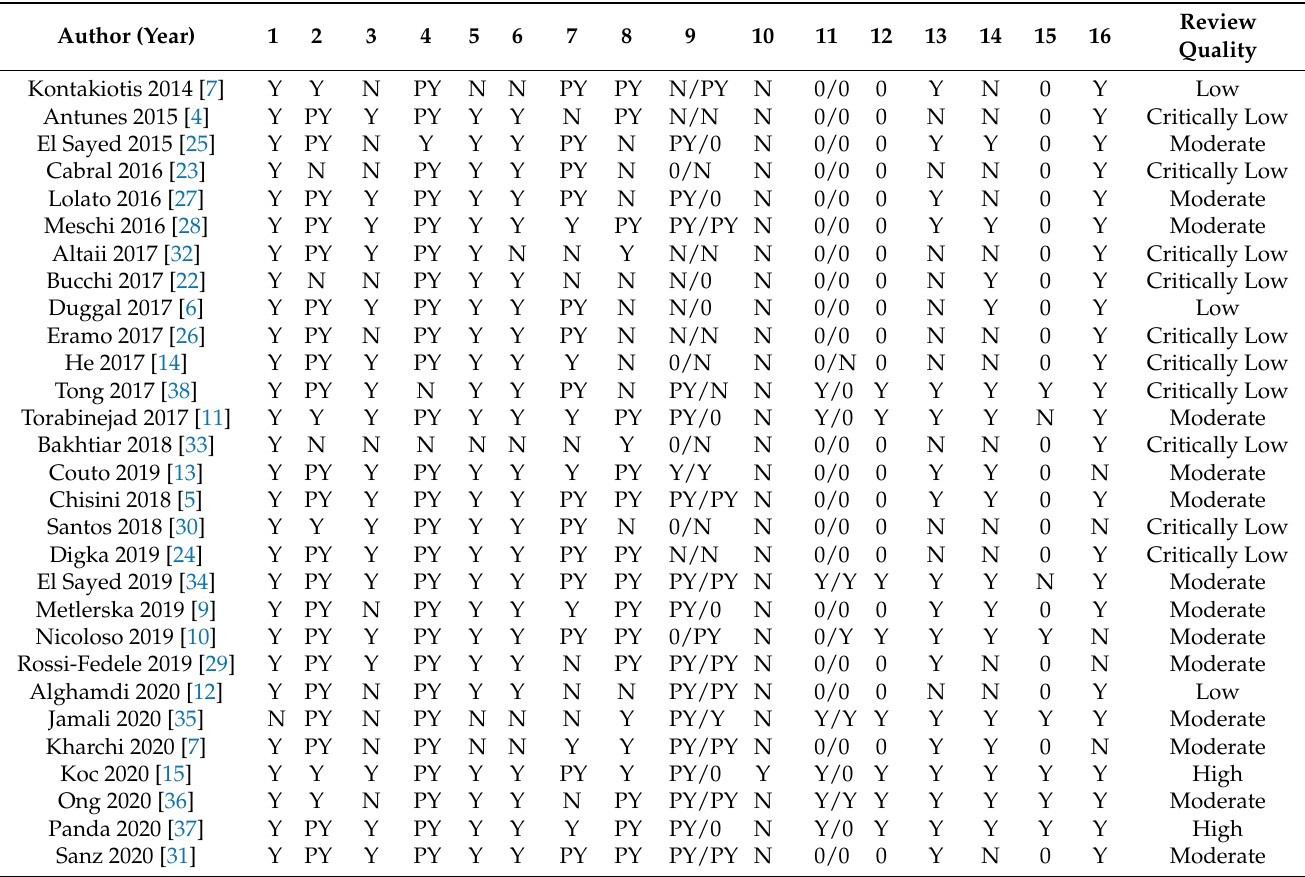
Table 2. Risk of Bias of Systematic Reviews (AMSTAR 2